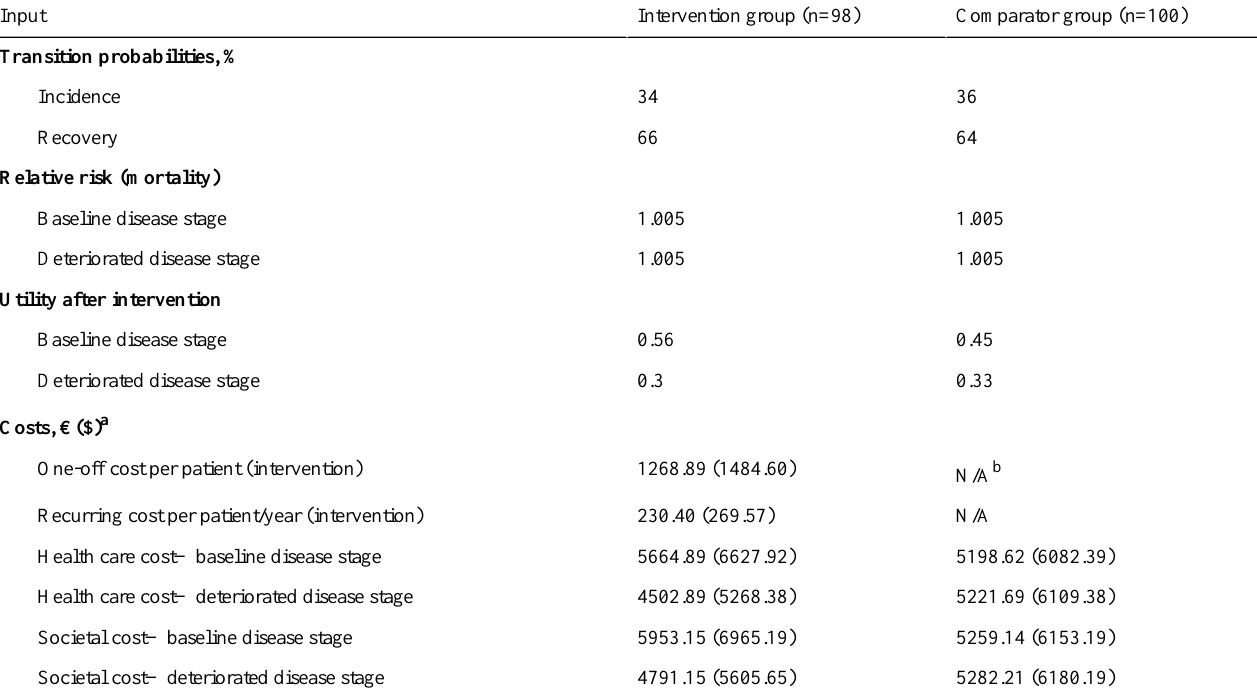
Table 4. Input used for the cost-effectiveness analysis based on the 3-state Markov model (N=198).